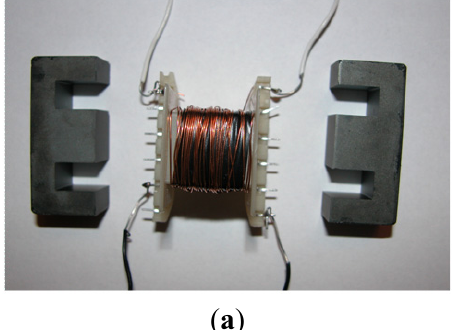
and two windings of 15 turns; ( c ) 2D computational domain; ( d ) inductor used in the 3D simulations; ( e ) cross-section S of the lateral column of the core in the x - z plane where e is the core